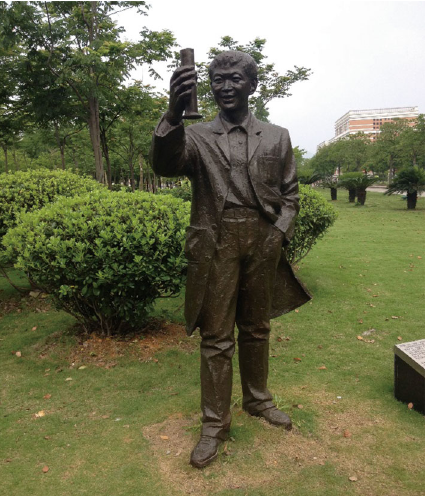
Figure 1. Statue photo of Dr. Jian Zhou on the campus of Wenzhou Medical University.